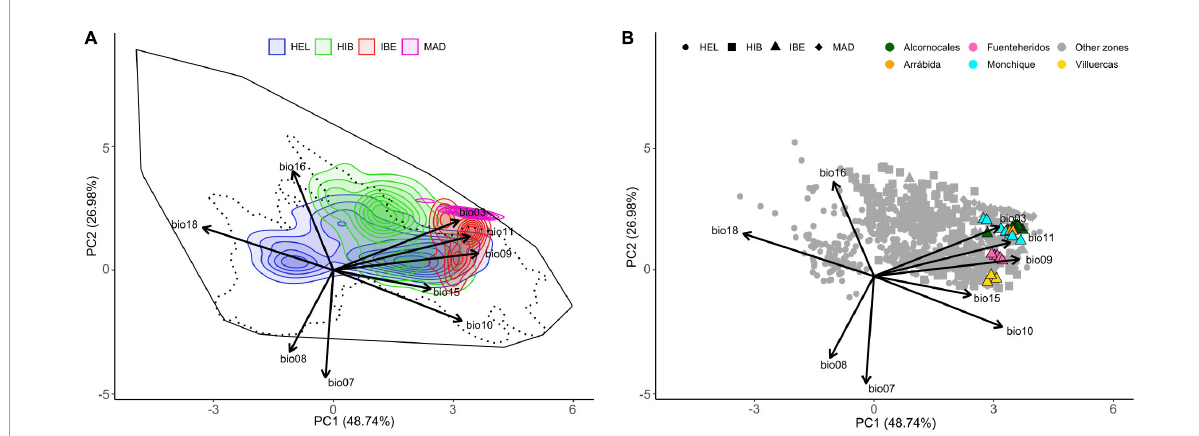
FIGURE3 Climatic niche ordination analysis. (A) Climatic niche space of the three species of the western polyploidy clade of Hedera ( H. hibernica , H. iberica , H. maderensis ) and H. helix as inferred from their entire geographical ranges. The colors of the density envelopes correspond to species, with shading intensity indicating the density based on point occurrences. The solid black line delimits the multivariate space corresponding to the 100% of the available environment for all the species, and the dotted line contains the 95% of the available environment. (B) Climatic space occupied by the geographical lineages of H. iberica according to the GBS phylogeny ( Figure 2 ). Contributions of the original WorldClim variables are provided: bio03, isothermality; bio07, temperature annual range; bio08, mean temperature of wettest quarter; bio09, mean temperature of driest quarter; bio10, mean temperature of warmest quarter; bio11, mean temperature of coldest quarter; bio15, precipitation seasonality; bio16, precipitation of wettest quarter; bio18, precipitation of warmest quarter. HEL, Hedera helix ; HIB, Hedera hibernica ; IBE, Hedera iberica ; MAD, Hedera maderensis .